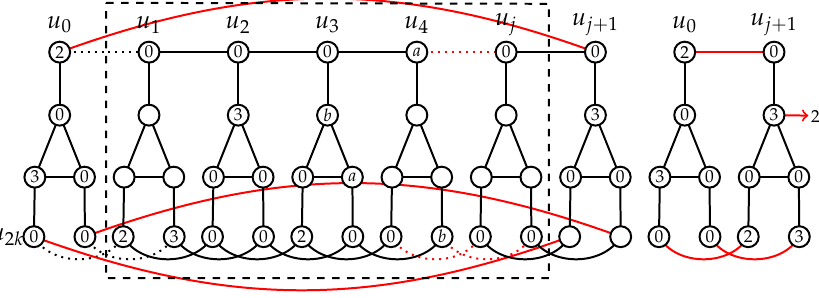
Figure 10. Case 2.1 of Lemma 9: f ( v j + 1 + k ) = 3.